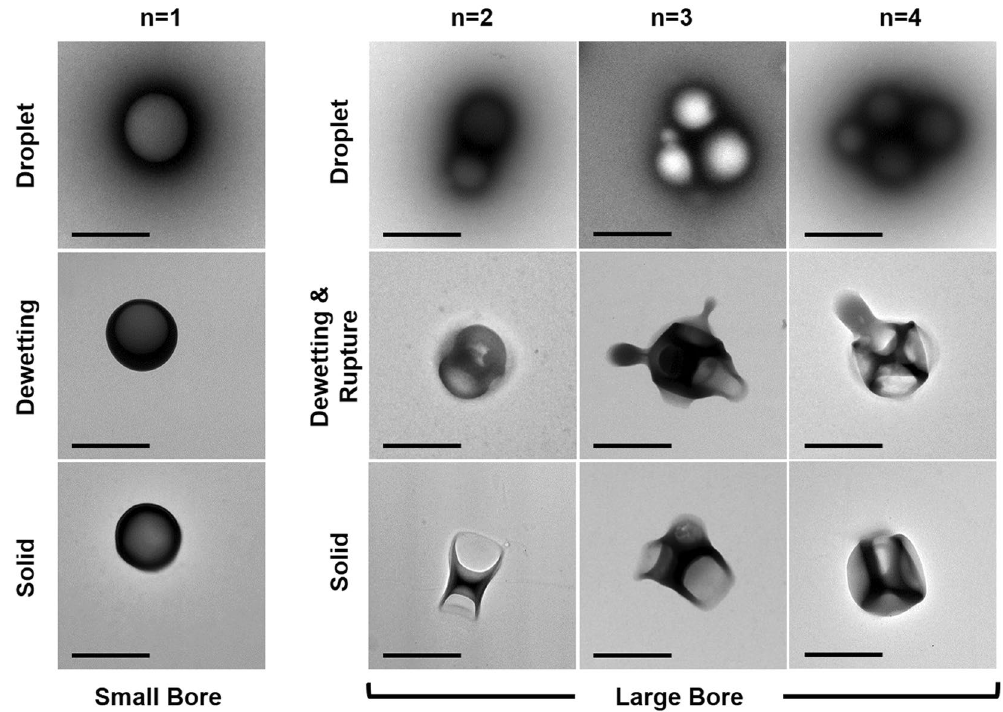
Figure 2. Representative TEM images showing the formation of RhB-hsPLGA and RhB-mcPLGA MPs. The scale bars represent 1 μ